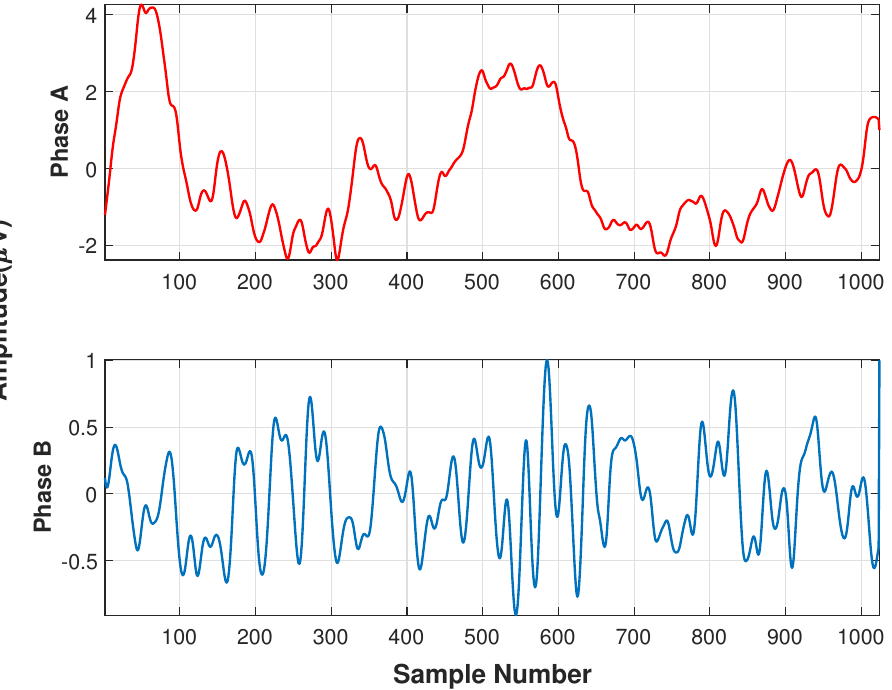
Figure 2. Typical waveforms of Phase A ( top ) and Phase B ( bottom ). High amplitude slow EEG waves increases with increasing depth of sleep whereas low amplitude fast rhythms are dominantly present in REM sleep. CAP phase A is subdivided into three subtypes A1, A2, and A3 based on the duration of high amplitude slow waves and low amplitude fast rhythms. Subtype A1 is characterised by high amplitude slow waves covering >80% of entire phase A duration and low amplitude fast rhythms, if present, covers <20% of total phase A duration. Subtype A2 is characterised by a mixture of fast and slow EEG waves. Low amplitude slow waves in phase A2 covers around 20–50% of entire phase A duration. Subtype A3 is characterised by dominant low amplitude fast rhythms covering >50% of the phase A duration. CAP sequences triggered or interrupted by body movements are also distinguished as subtype A3 [22]. The CAP parameters include CAP rate, CAP time, and no of phases A1, A2 and per hour. Cap rate refers to the